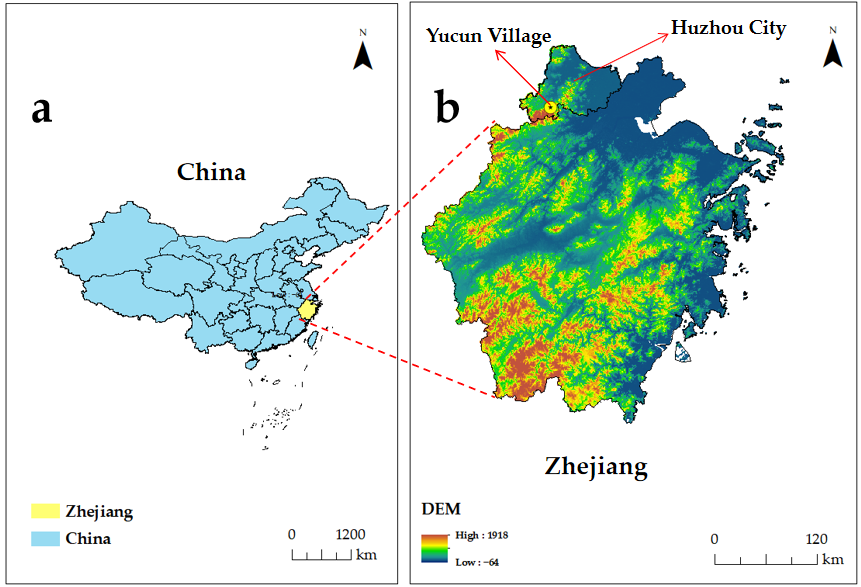
Figure 2. ( a ) Geographical location of Zhejiang Province. ( b ) Geographical location of Yucun Village of Huzhou City.